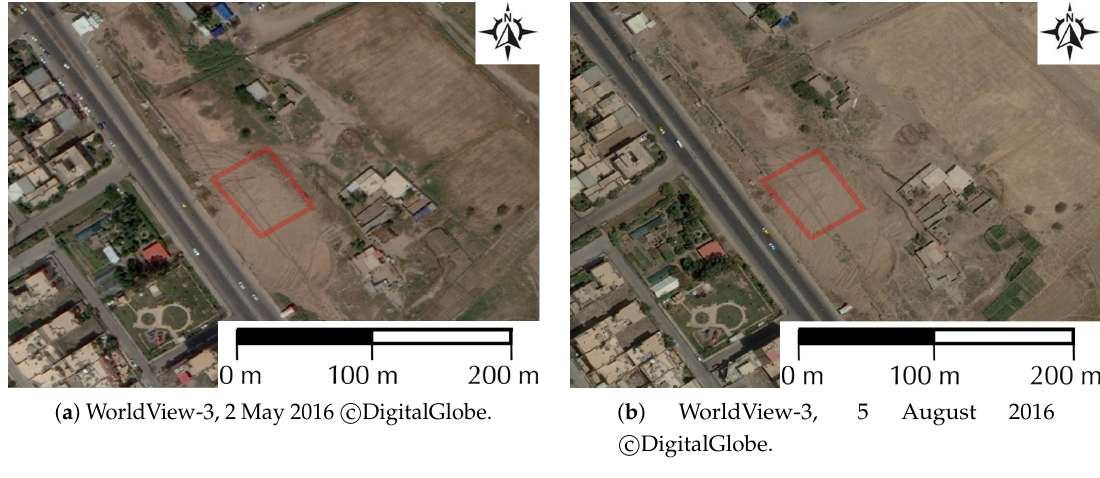
Figure 32. Satellite imagery of Mashki Gate (2016).